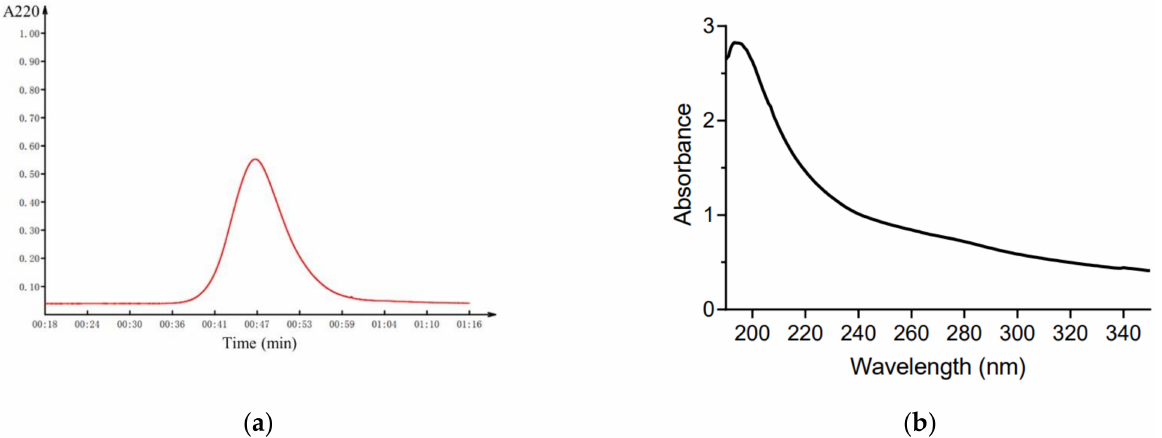
Figure 1. Purity of purified M-EPS. ( a ) Elution profile on Sephadex G-100 column; ( b ) UV spectrum over the range 190–350